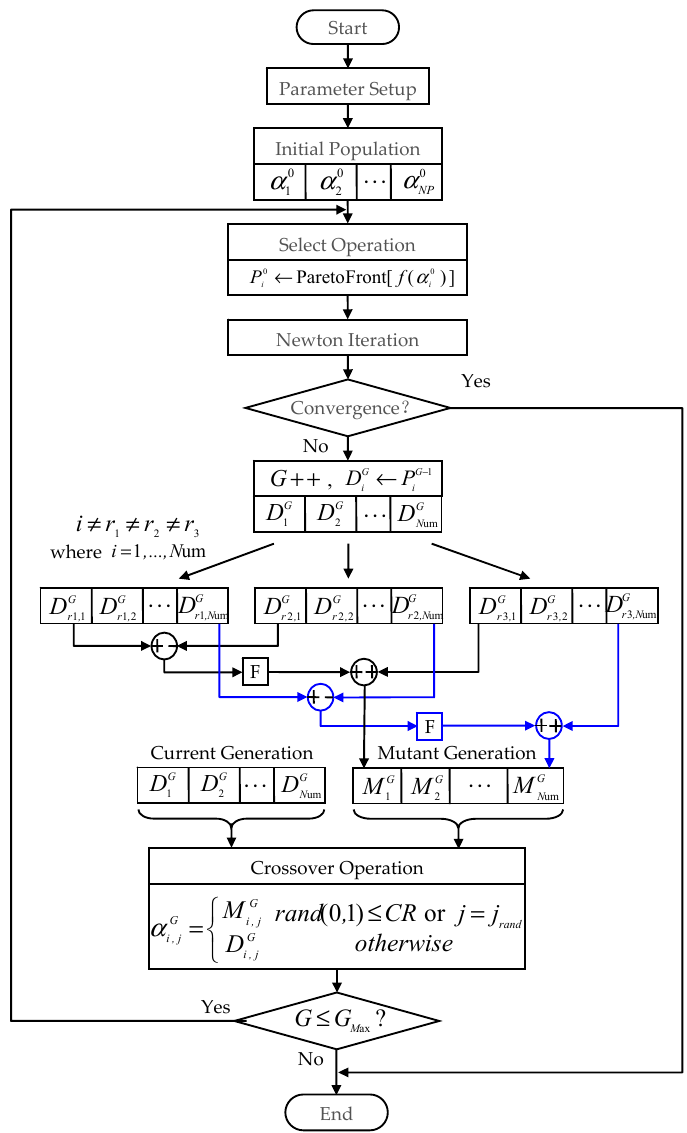
Figure 3. Flowchart for the improved DE optimization.